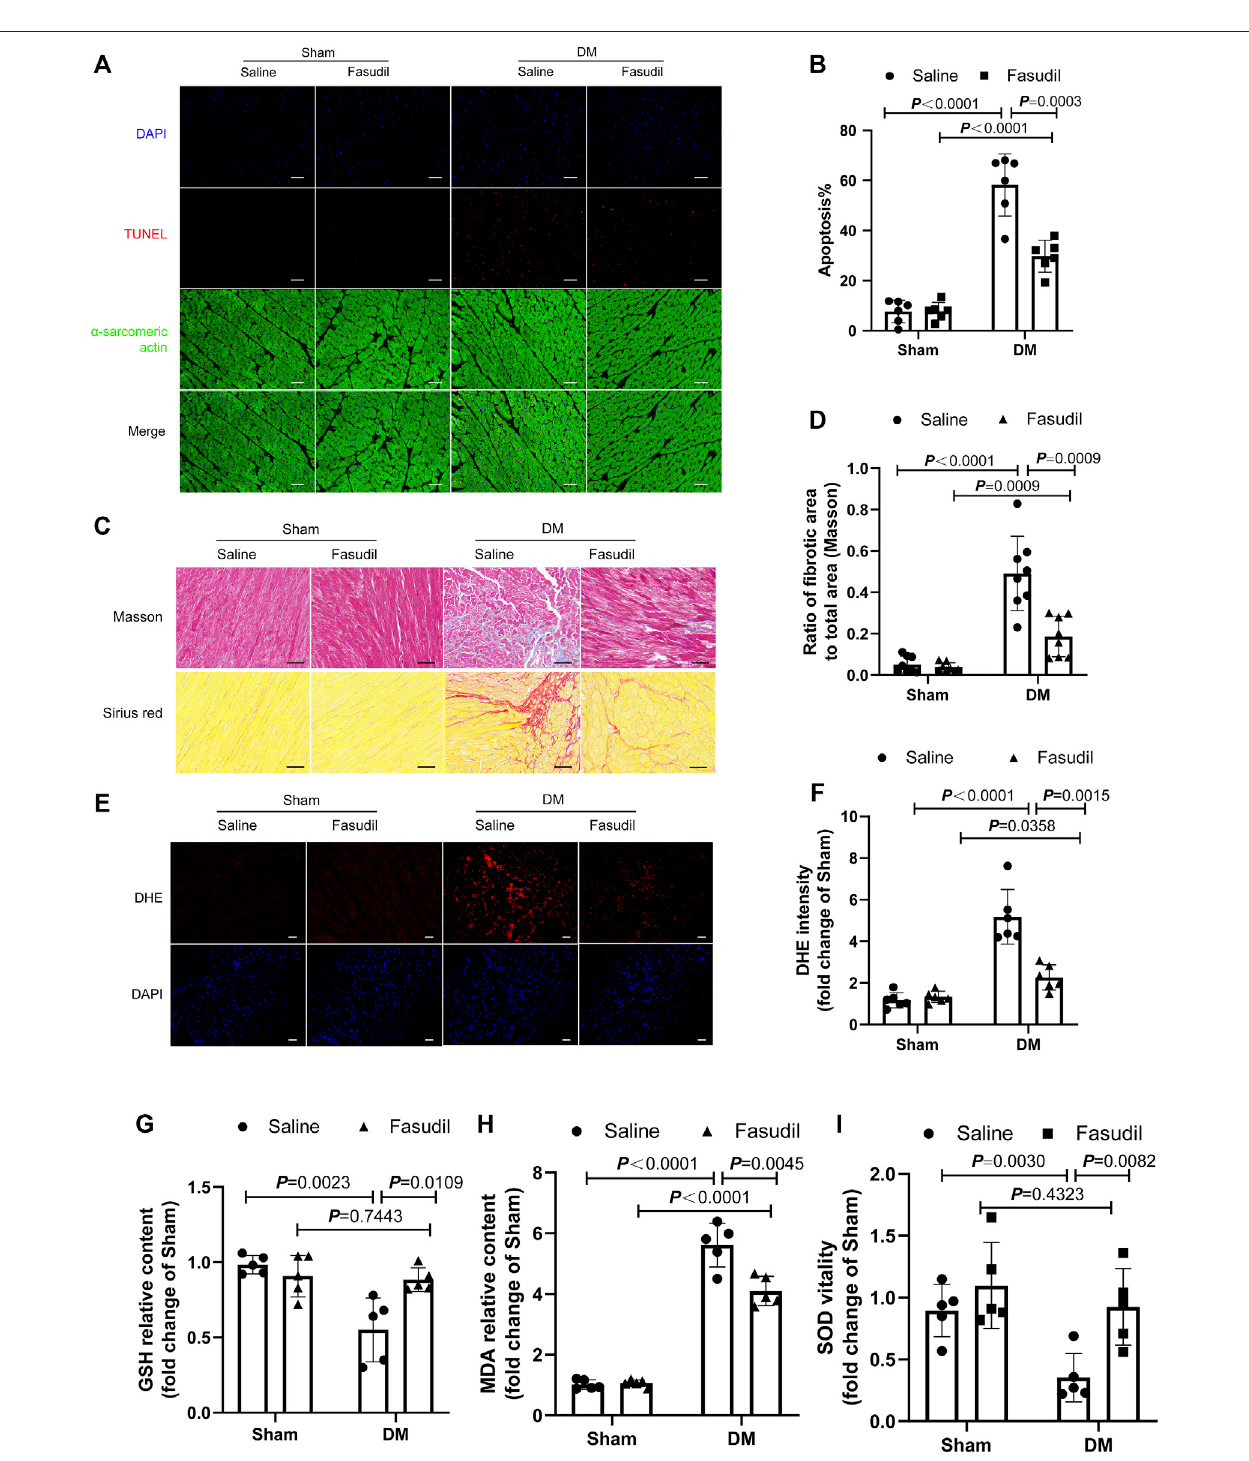
FIGURE 3 | Fasudil improved DM-induced myocardial apoptosis, fi brosis and oxidative stress (A,B) Representative sections showing TUNEL and anti-alpha- sarcomeric actin staining and the quanti fi cation of TUNEL. Cardiomyocyte apoptosis was analyzed quantitatively (n = 5). Scale bar = 100 μ m (C,D) Images illustrating Masson and Sirius red staining and quanti fi cation. Ratio of the fi brotic area to the total area was analyzed quantitatively. Scale bar = 50 μ m (n = 8) (E,F) Representative sectionsofdihydroethidium(DHE)stainingandquanti fi cation(n=6).Scalebar=100 μ m (G – I) HearttissueGSH,MDA,andSODweredetermined(n=5). p -values were adjusted for comparisons of multiple